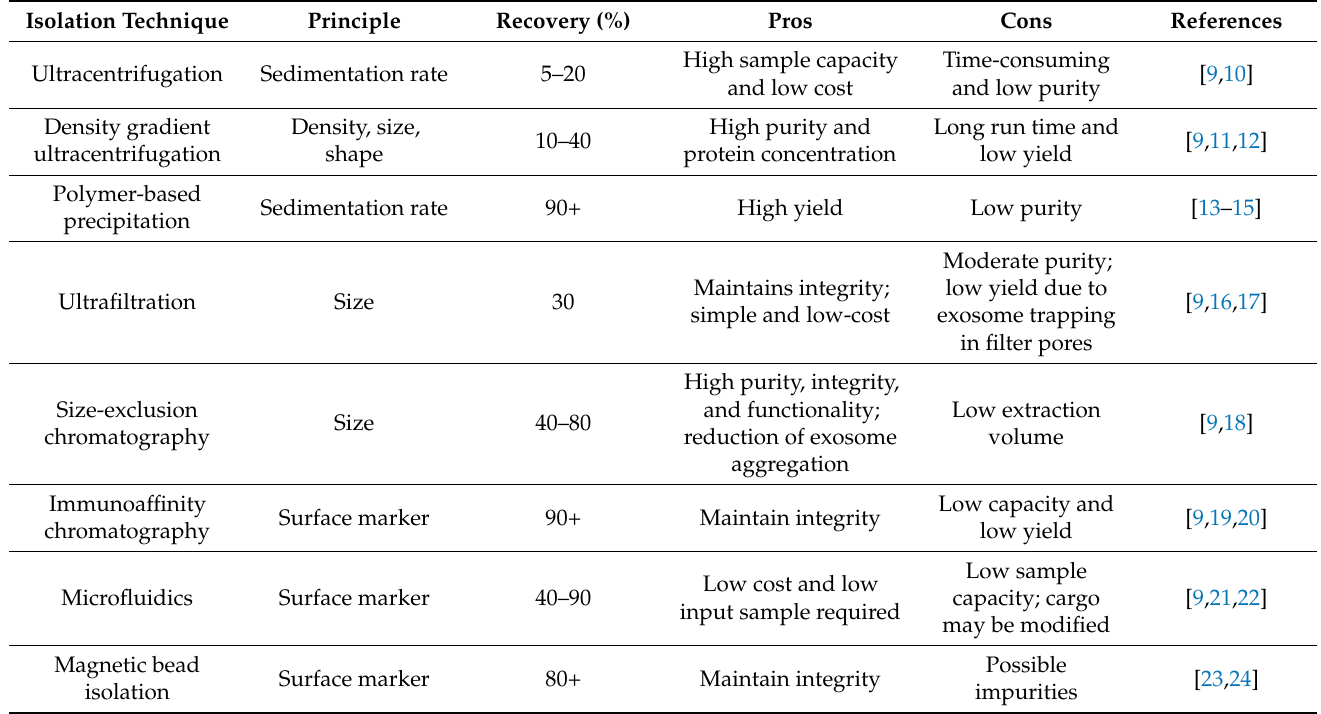
Table 1. Comparison of different downstream exosome isolation techniques. The table summarizes the advantages and disadvantages of each technique and their reported exosome recovery